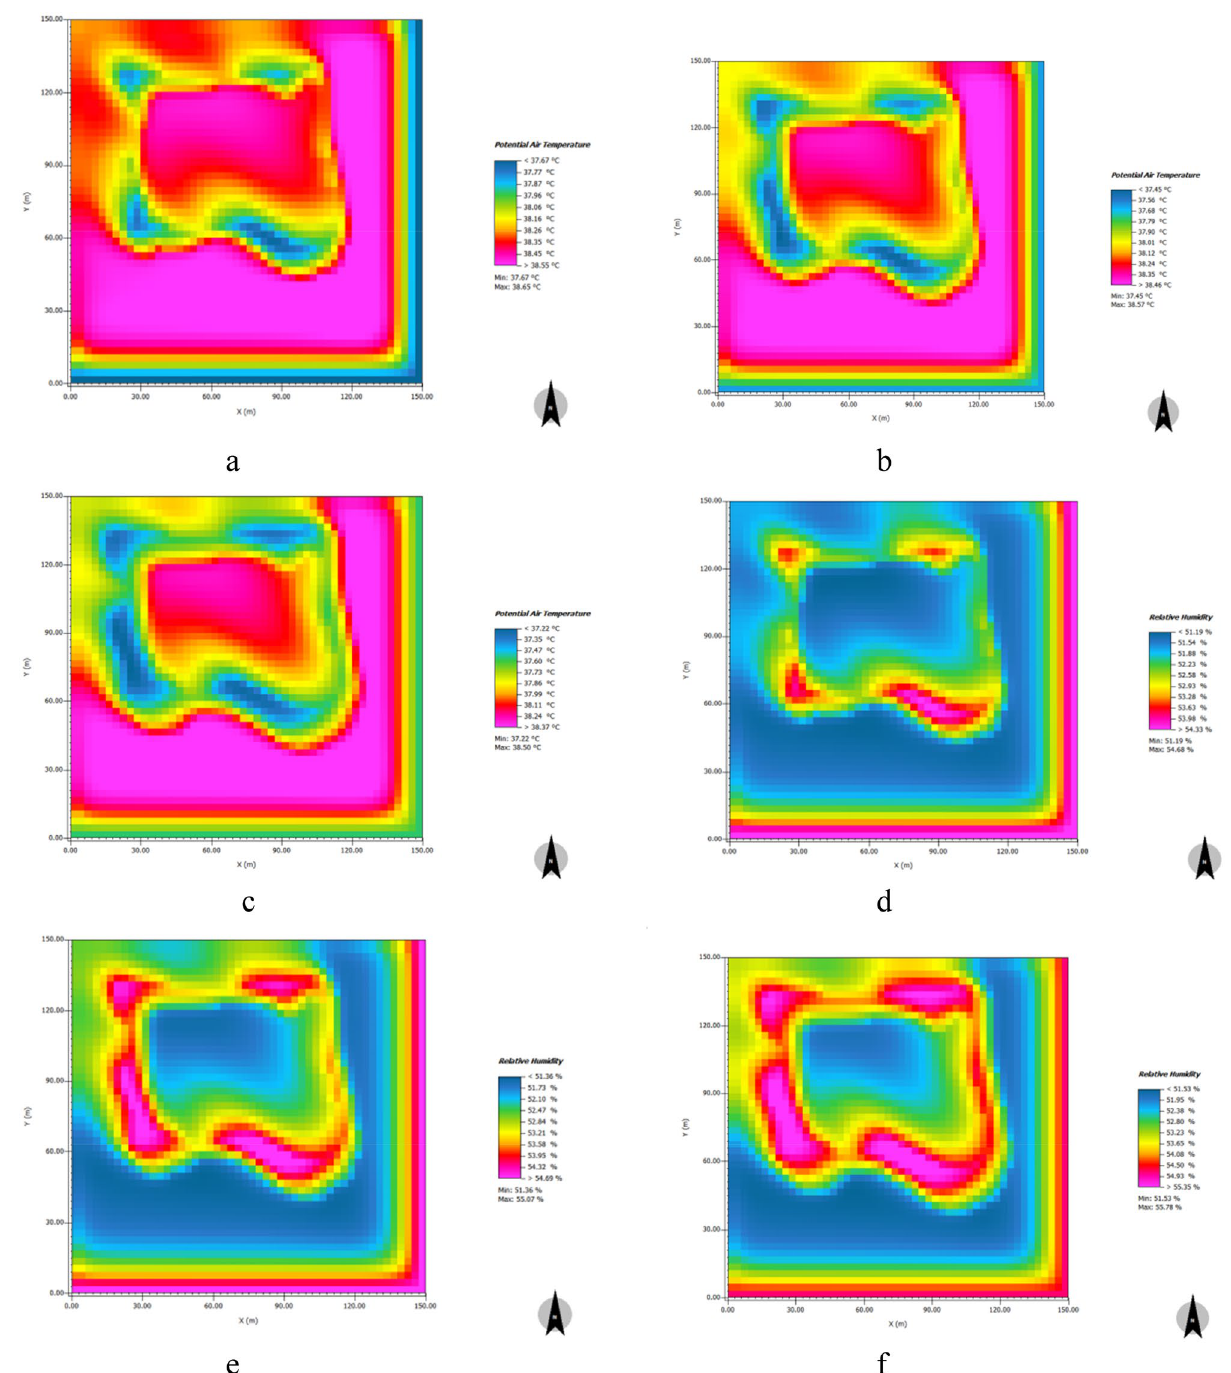
Figure 18. Distribution characteristics of cooling and humidifying effects of simulated increase of annular water area at 14:00. ( a ) original cooling effect of annular water in the sample area; ( b ) cooling effect of 5% increase in water area; ( c ) cooling effect of 10% increase in water area; ( d ) original humidifying effect of annular water in the sample area; ( e ) humidifying effect of 5% increase in water area; ( f ) humidifying effect of 10% increase of water